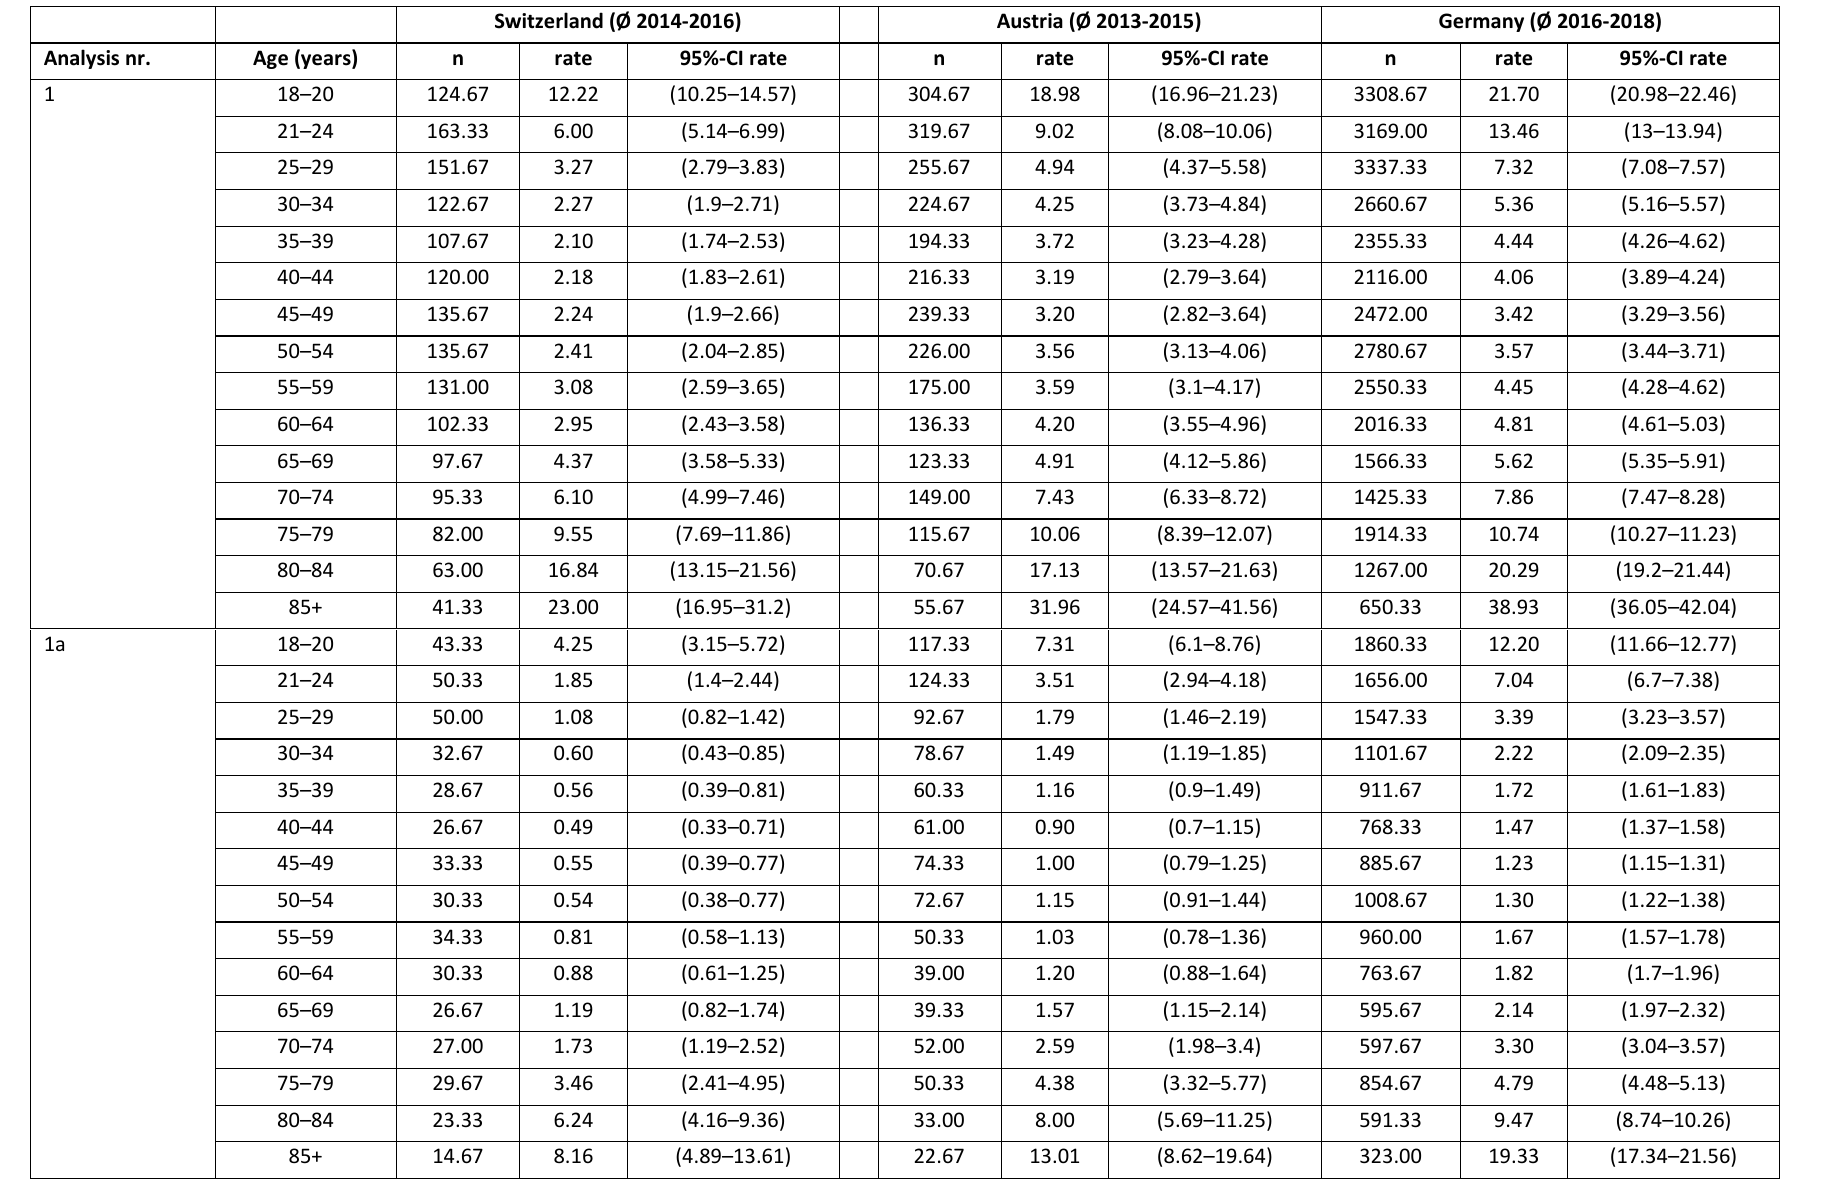
Table S1: Numerical values (rates) corresponding to Figures 2-5 including total number of accidents and injuries, respectively.